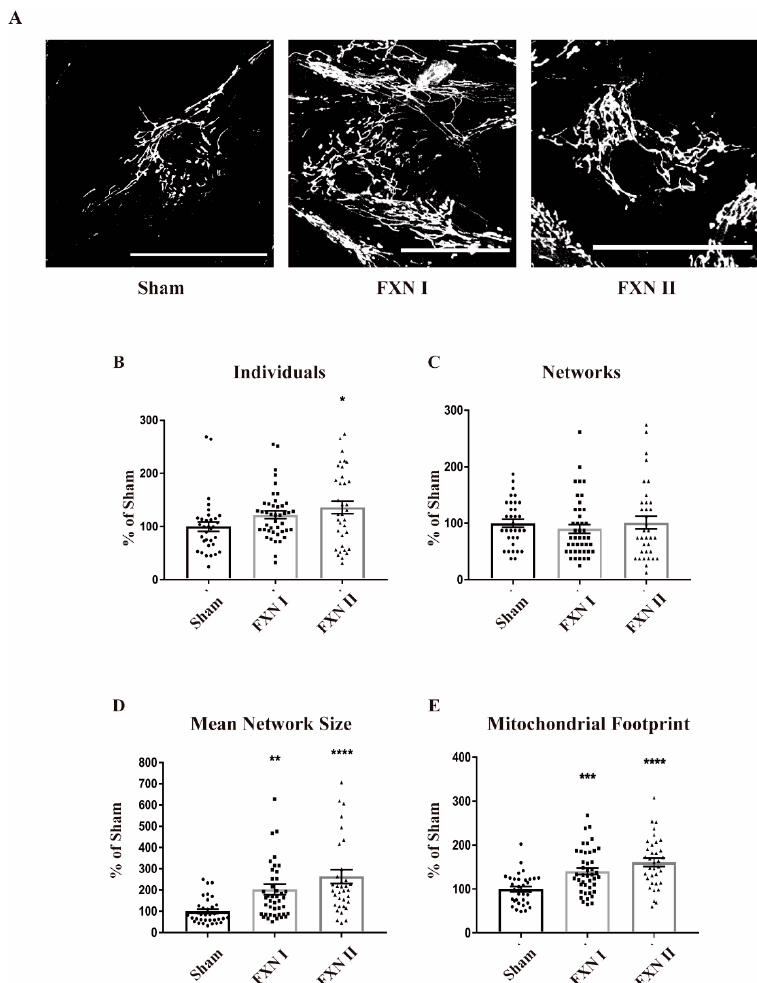
Lv-FXN II (right) and stained with Mitotracker. Calibration bar represents 50 µm. ( B ) to ( E ) Analysis and quantification of OE-MSc mitochondrial network morphology with MiNA. ( B ) Percentage of raw number of individual mitochondria. ( C ) Percentage of mitochondria arranged in a networked junctioned structure. ( D ) Number of branches per knot. ( E ) Total mitochondrial footprint, indicating the quantity of signal versus background in the image. Data represents mean ± SEM of at least three independent cell culture preparations ( n = 3). Data were analyzed by one-way ANOVA test with post hoc Dunnett multiple comparisons test. * p < 0.05; ** p < 0.01.